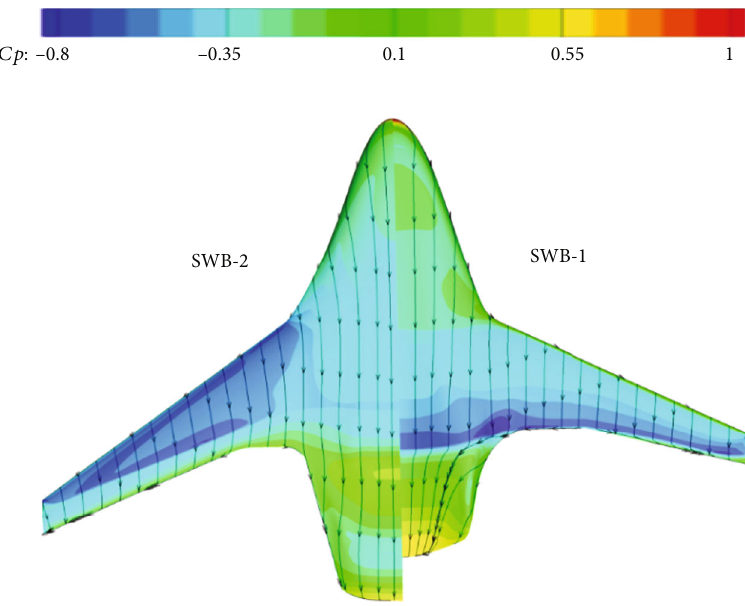
Figure 14: The surface pressure and streamlines of SWB-1 and SWB-2 at cruise speed, α = 1 : 5 °